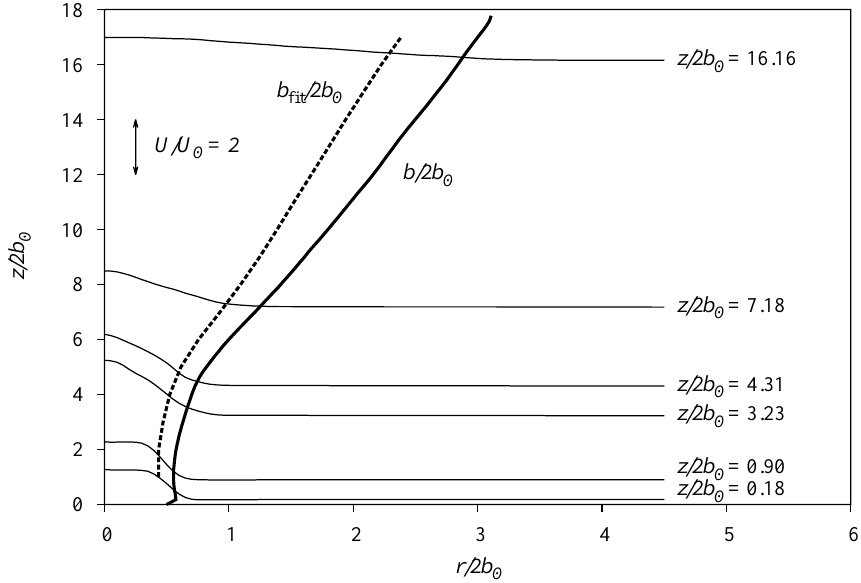
Figure 13. Radial profiles of the time-averaged velocity field at various height. The scale for these profiles is indicated by the up-down arrow on the left in the panel. The thick solid line is the plume radius evaluated from the mass, momentum and buoyancy fluxes, while the thick dashed line is the plume radius evaluated from Gaussian fits of horizontal profiles.